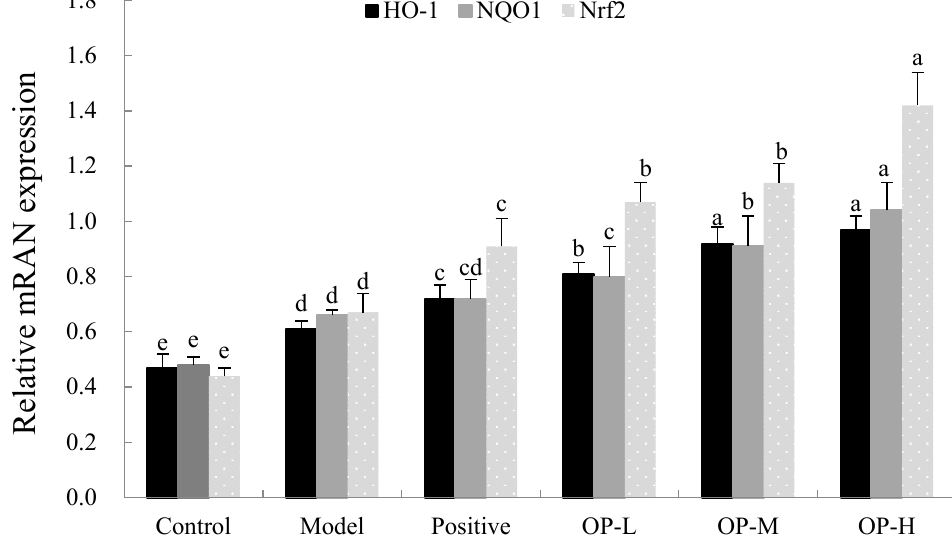
Figure 9. The mRNA expressions of HO-1, NQO1, and Nrf2 in liver of different groups (means ± SD, n = 10). Bars with different superscripts (a, b, c, d and e) were significantly different ( p < 0.01) according to ANOVA using the SPSS software and means were compared by Duncan’s multiple comparison post-test.